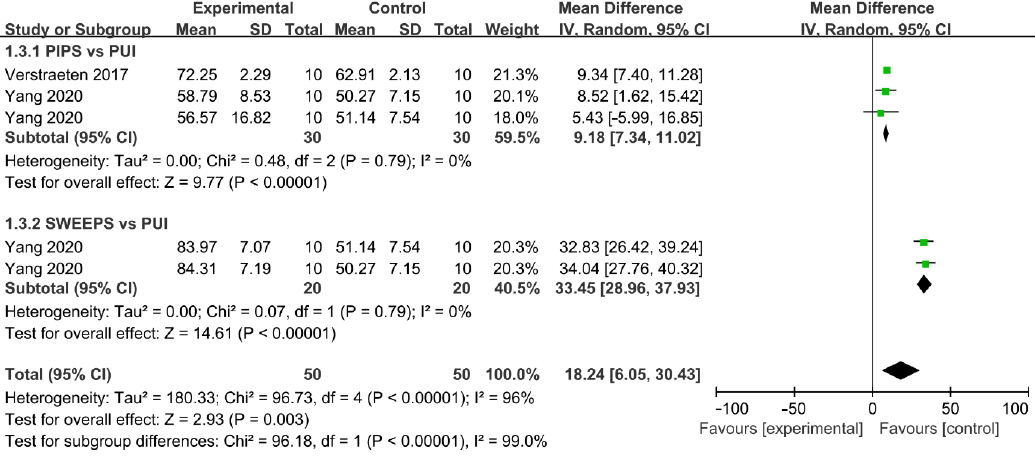
Figure 8. Forest plot and meta ‐ analysis of comparison between LAI and PUI [15,41].